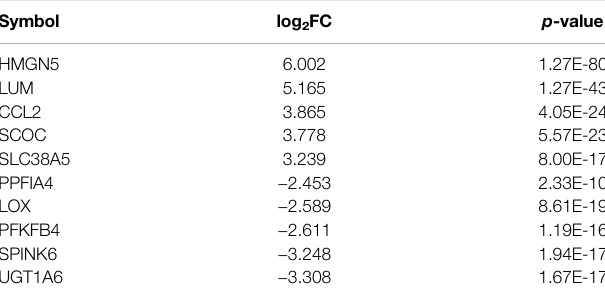
TABLE 4 | DEGs with most difference in expression when HIF1A was knocked out. Symbol